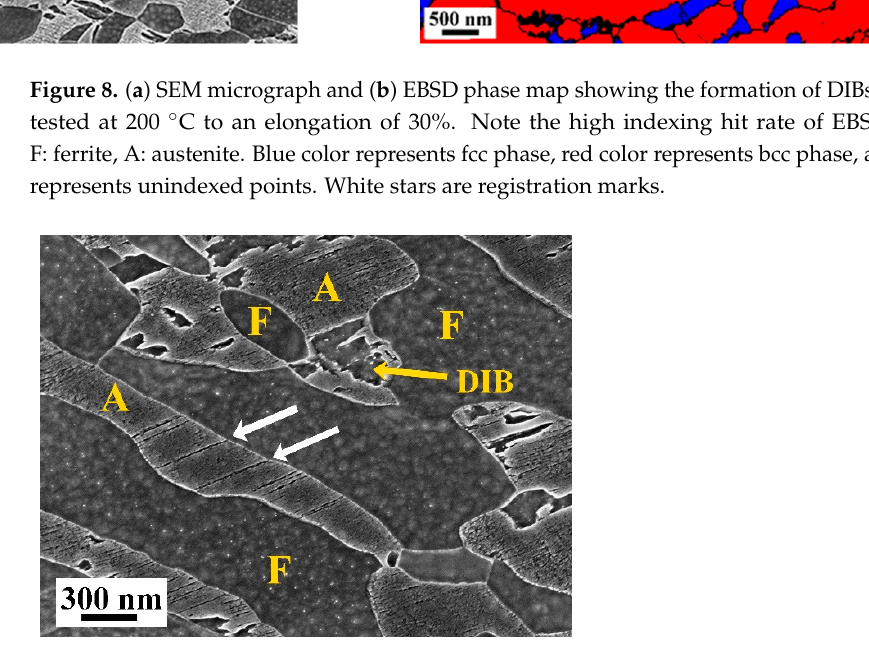
Figure 9. SEM micrograph showing the presence of twin-like traces in some austenite grains in a specimen tested at 200 °C to an elongation of 30%, as marked by white arrows. F: ferrite, A: austenite.